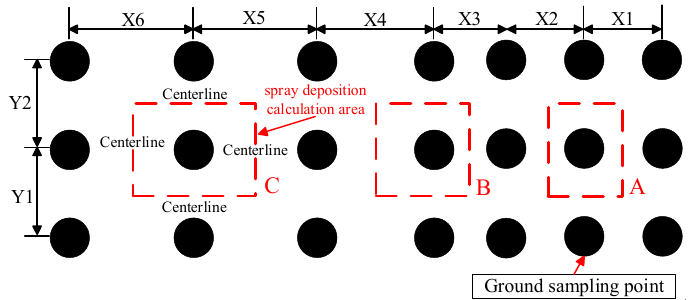
Figure 9. Schematic diagram of the ground deposition calculation.